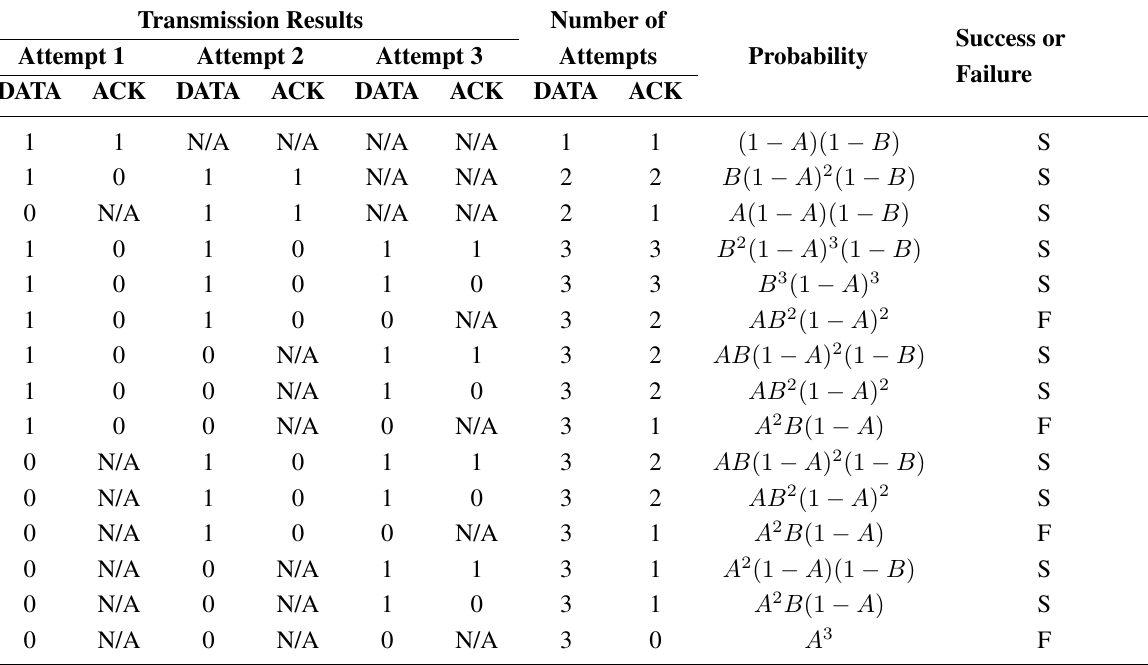
Table 1. Data transmission possibilities in a certain